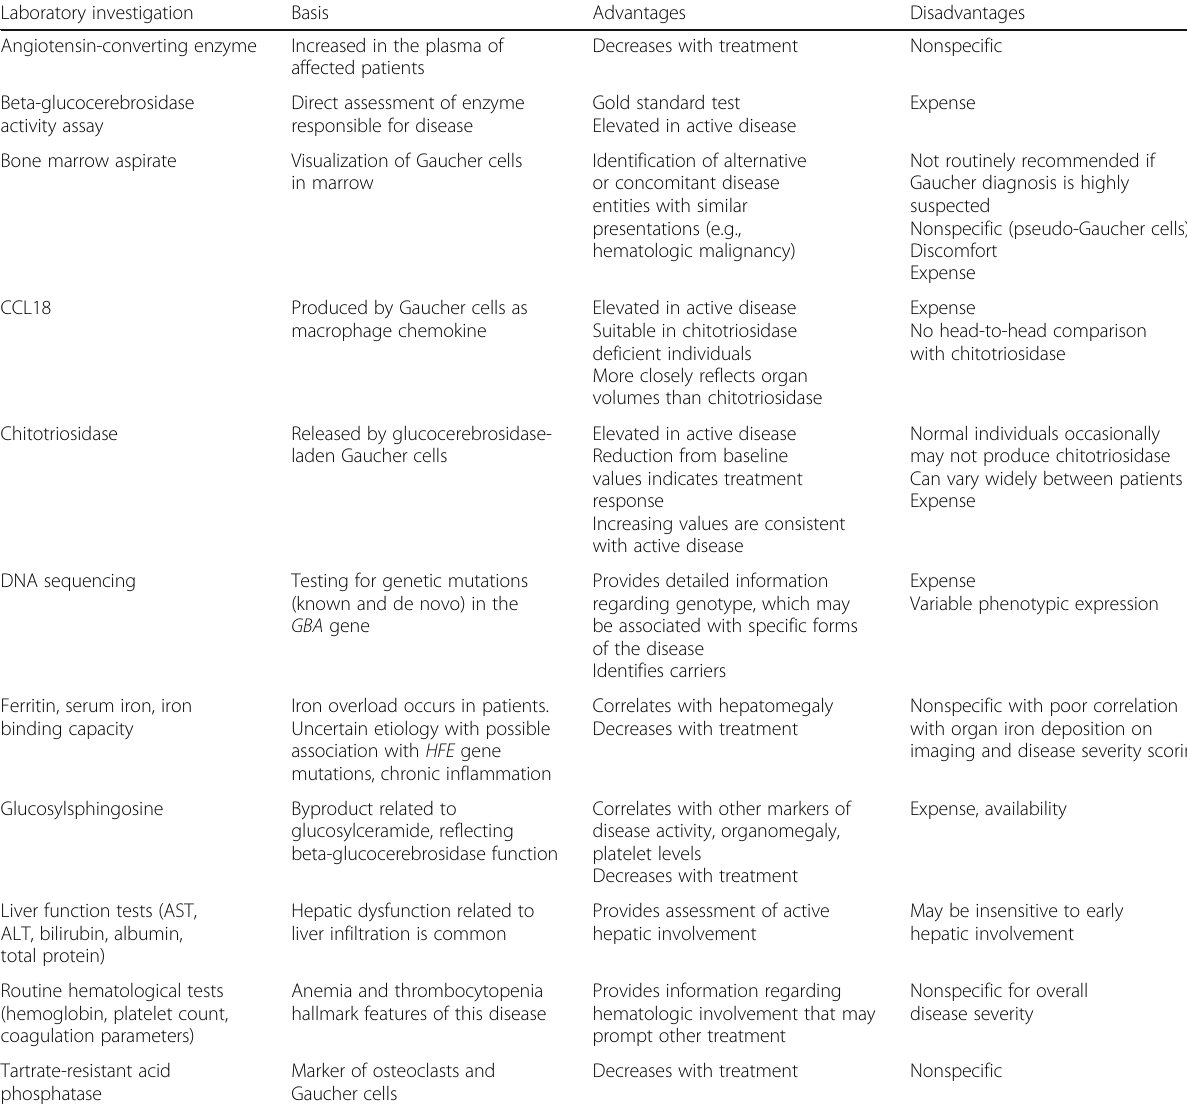
Table 2 Laboratory investigations in Gaucher disease Laboratory investigation Basis Angiotensin-converting enzyme